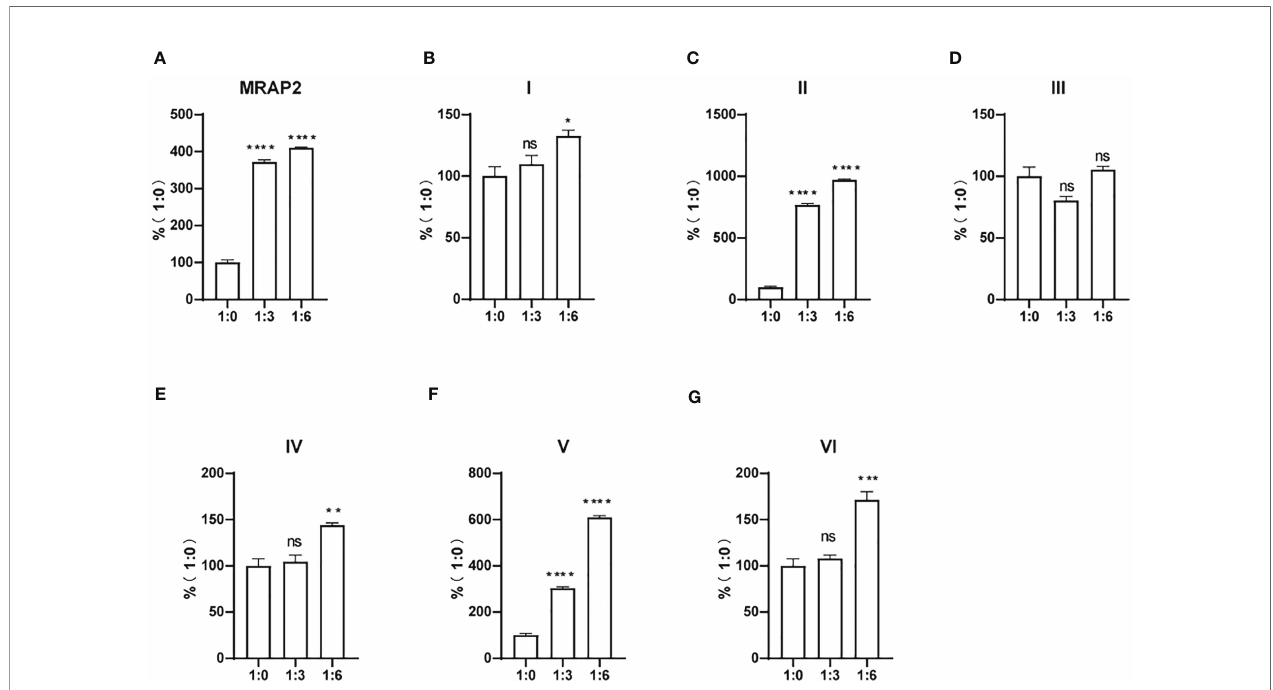
FIGURE 4 | Pharmacological modulation of the constitutive activities of melanocortin-4 receptor (MC4R) by melanocortin receptor accessory protein 2 (MRAP2) variants. (A – G) cAMP production measurement of the constitutive activities of MC4R in the presence of various doses of the MRAP2 variants. Data are shown as the mean ± SEM and analyzed using two-tailed test. ns (no signi fi cant change), * p < 0.05,** p < 0.01, *** p < 0.001, **** p < 0.0001. Each data column represents the mean ± SEM of three replicates ( N =